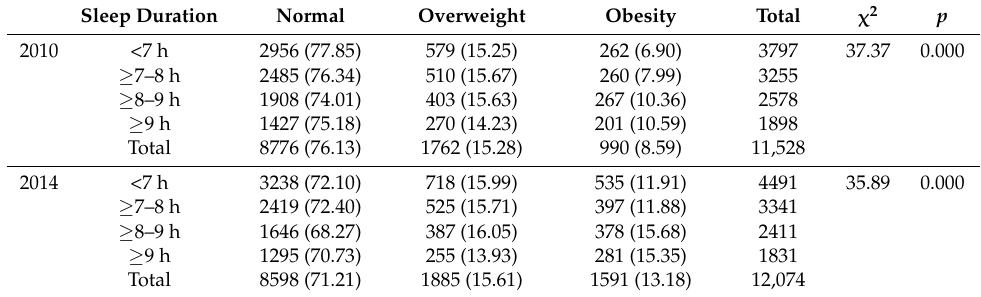
Table 4. The prevalence of obesity and overweight among different sleep duration groups in 2010 and 2014 (%).